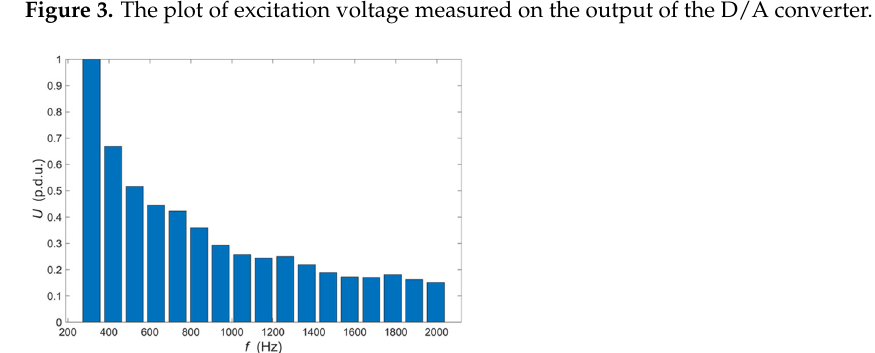
Figure 4. The amplitudes of the harmonics used to synthesize excitation voltage waveform shown in Figure 3.